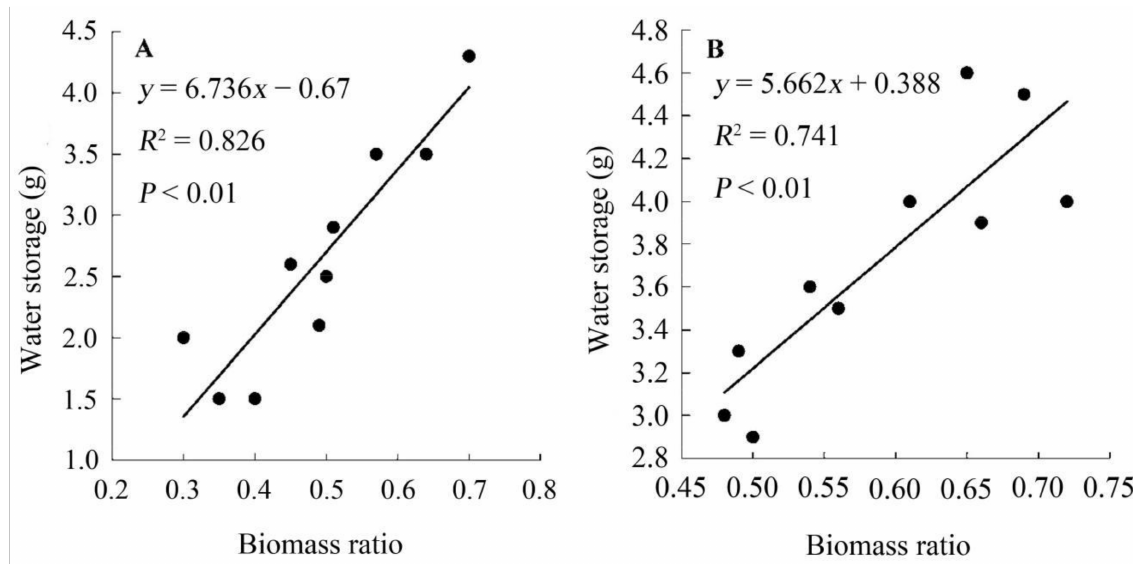
Figure 6. Linear regression relationship between water storage volume of branches and the biomass ratio of leaf and branch/trunk for C. korshinskii and H. rhamnoides . ( A ) C. korshinskii . ( B ) H. rhamnoides